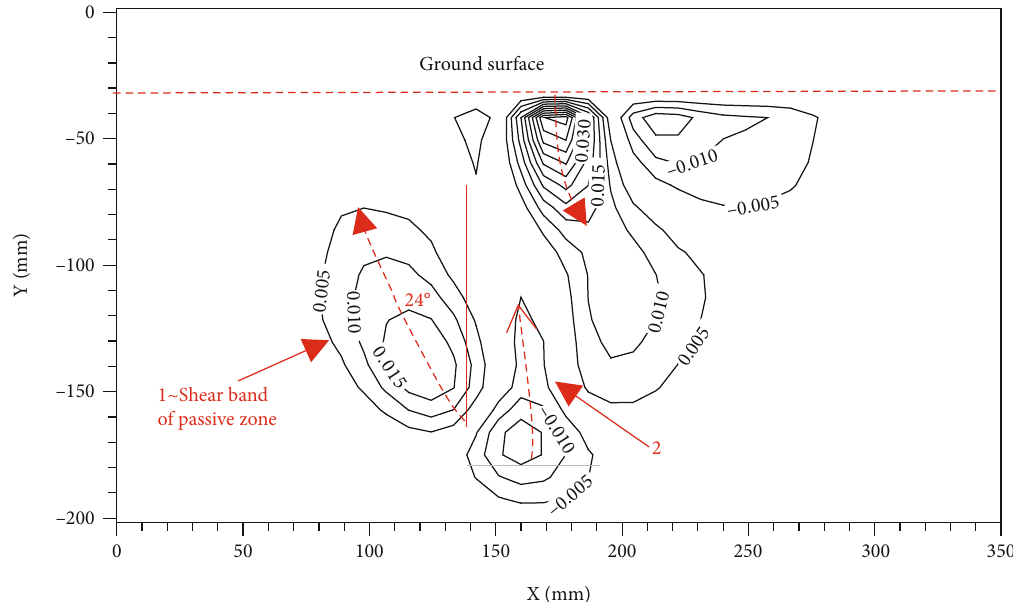
Figure 14: Shear strain fi eld at the ultimate load for D